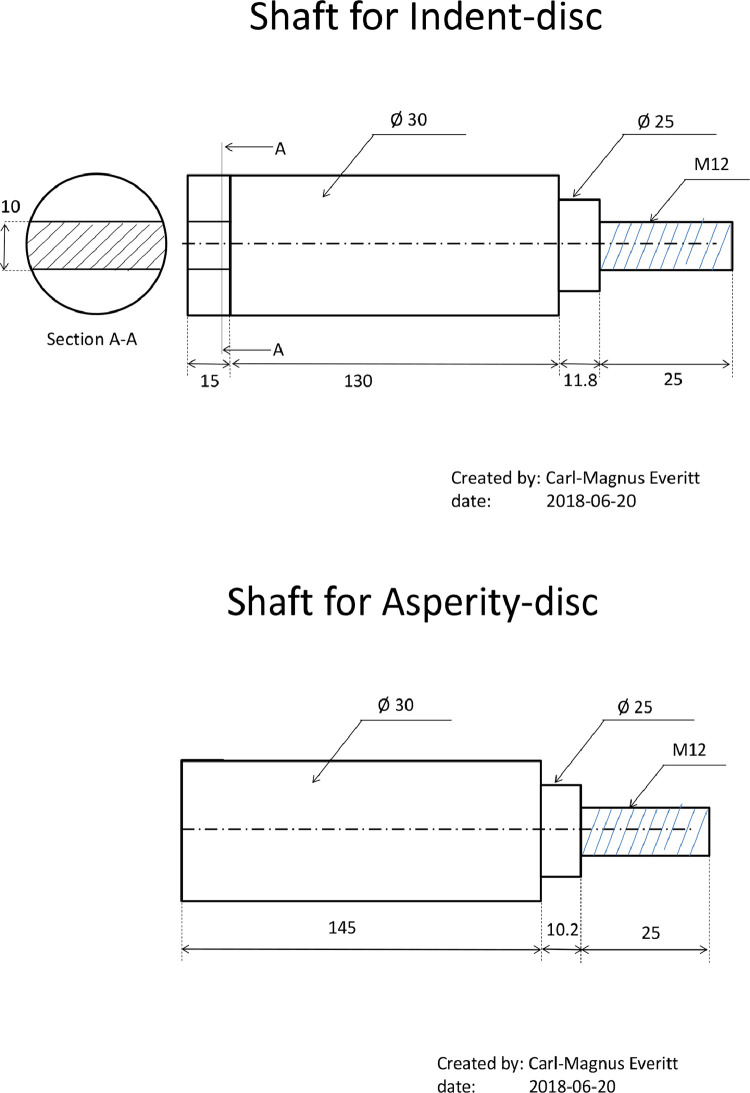
Drawings of the axis used in the set-up for creating the discs. The shaft for the indent-disc contains a tangible section to the left.